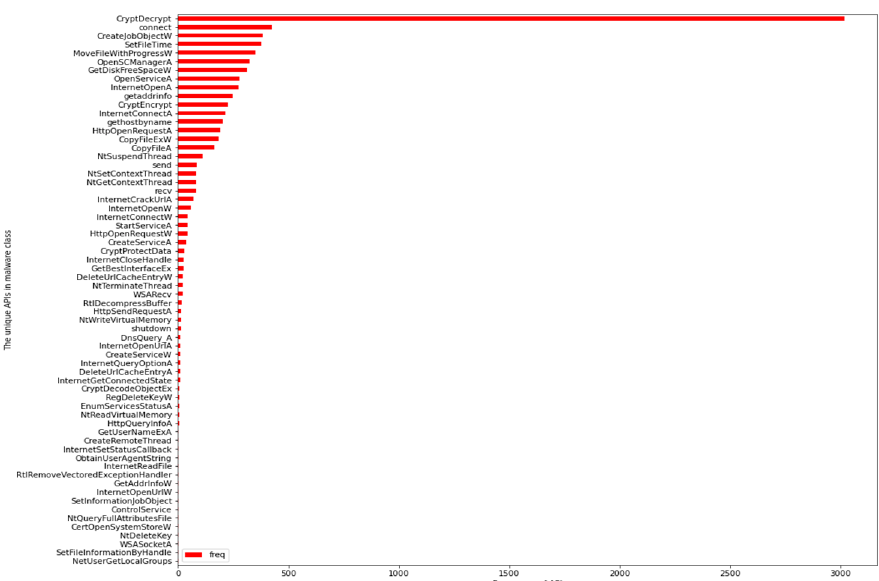
Figure 1. The unique API calls of legitimate class.